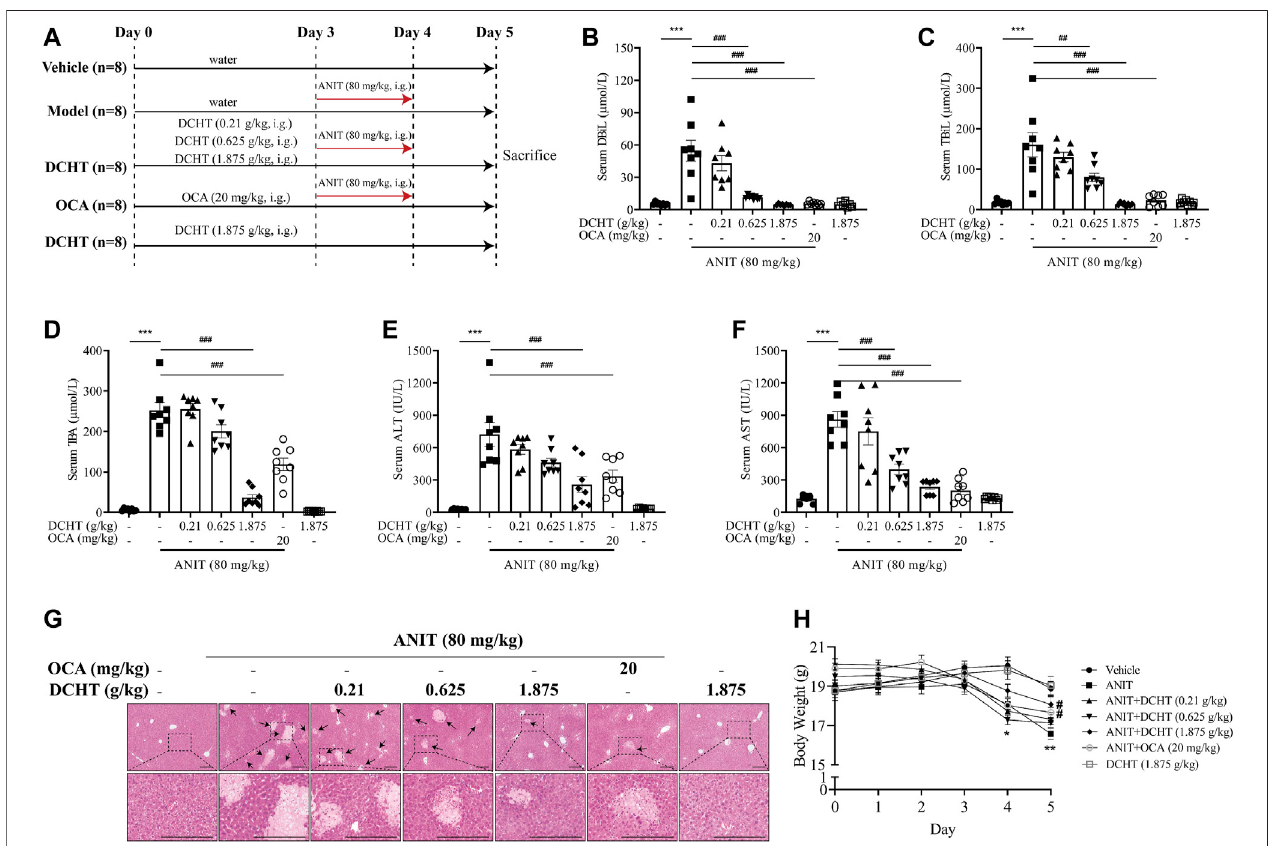
FIGURE 1 | DCHT alleviates ANIT-induced cholestatic liver injury in vivo . (A) Scheme of the experimental design. (B-F) Serum levels ofDBiL (B) , TBiL (C) and TBA (D) , ALT (E) and AST (F) . (G) H&E-stained liver sections. Scale bar = 200 μ m. Arrows indicate the area of severe liver necrosis and hyperplastic bile cytoderm. (H) Body weights of all animals were recorded daily. Data are shown as means ± SEM; * p < 0.05, ** p < 0.01, *** p < 0.001 as compared with the vehicle group. # p < 0.05, ## p < 0.01, ### p < 0.001 as compared with the ANIT-treated group, n =